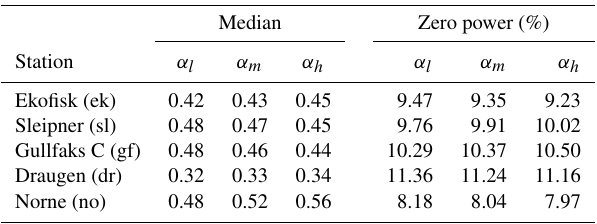
Table 5. Sensitivity in the median wind power production and the risk of zero power production as a function of the power-law expo- throughout the